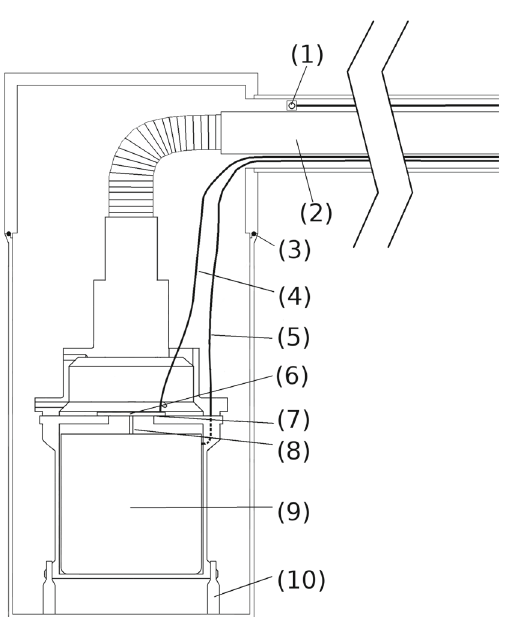
Fig. 6 Illustration of the main components inside a Conus cryostat end cap: 1. temperature sensor, 2. cold finger, 3. O-ring, 4. signal cable, 5. HV cable, 6. substrate with cold front end electronics (SMD resistor, JFETwithsolderedcontacts),7.insulator,8.contactpin,9.HPGediode,